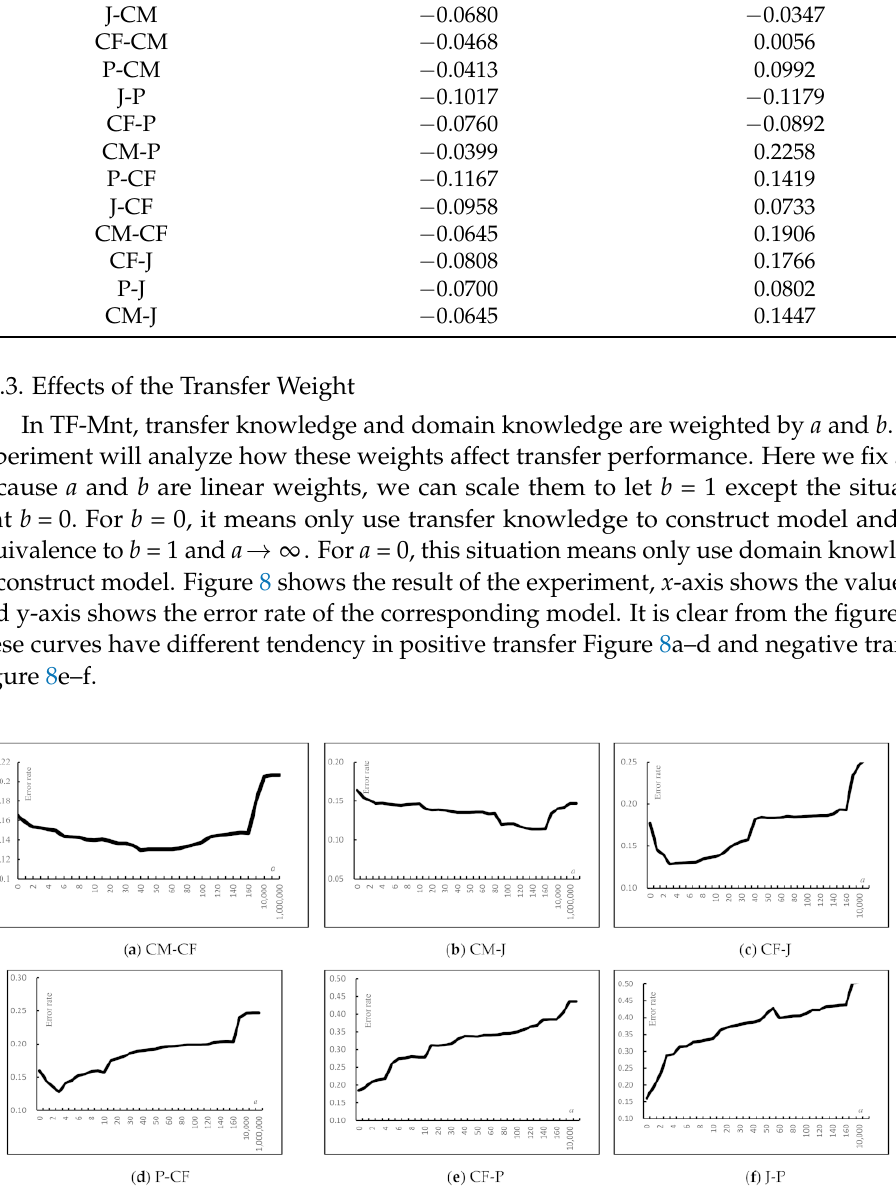
Figure 8. The effection of the transfer